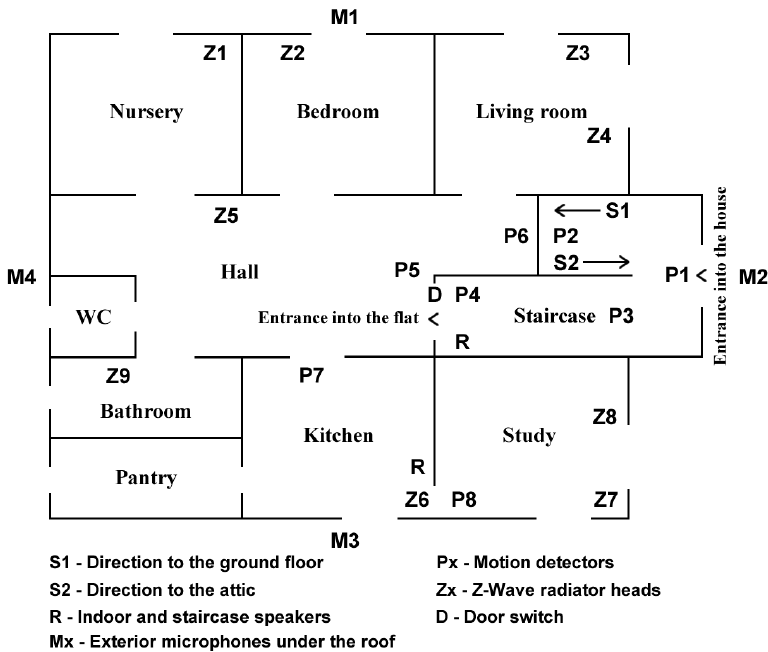
Figure 2. Plan of the flat in which a prototype of the system has been installed, and the placement of motion detectors and other input/output components of RUDO system. Source: Authors.